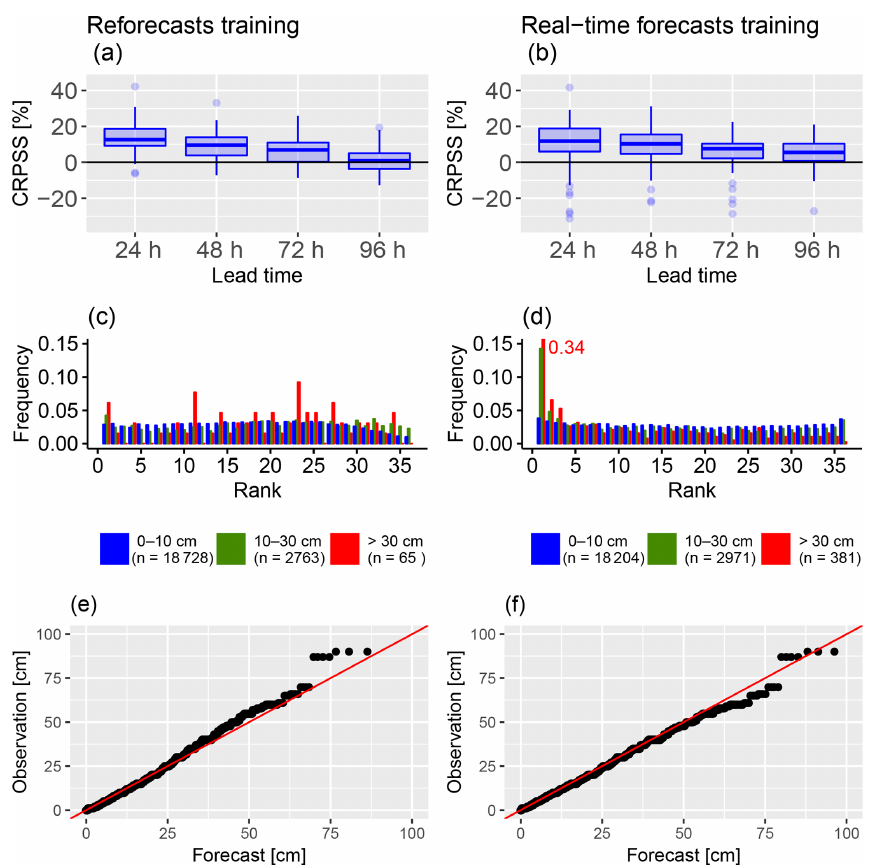
Figure 6. Comparison of post-processing skill between a training with the reforecasts dataset (1994–2016, left column) and a training with the real-time forecasts dataset (2014–2017, right column) for post-processed HN forecasts calibrated at the massif scale and evaluated during winter 2017–2018. (a, b) CRPS of HN (cm) as a function of prediction lead time; the boxplot represents the variability of scores between the 47 stations. (c, d) Rank histograms; the three HN classes are the same as in Fig. 3b. (e, f) Quantile–quantile